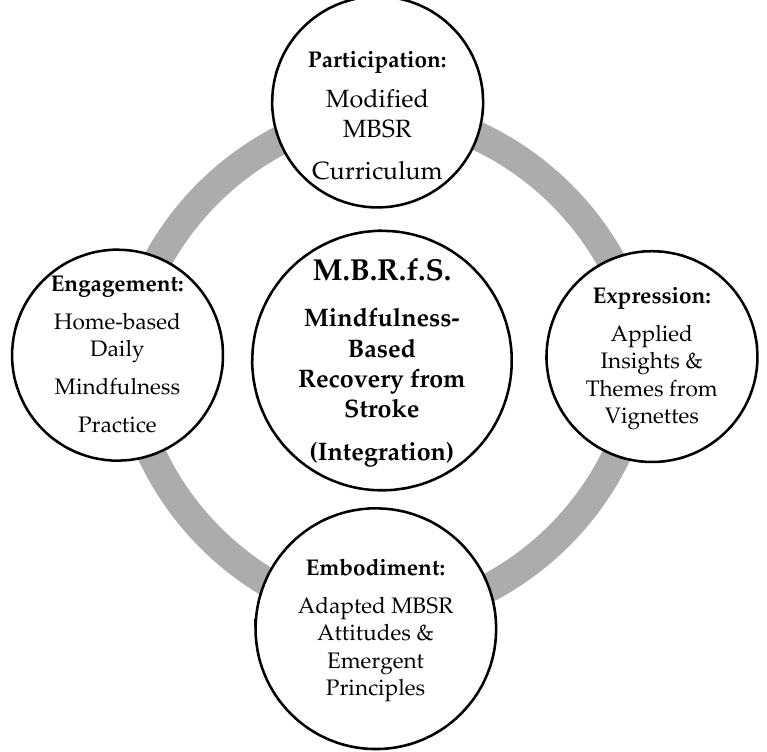
Figure 1. Preliminary conceptual model for Mindfulness-Based Recovery from Stroke (MBRfS).